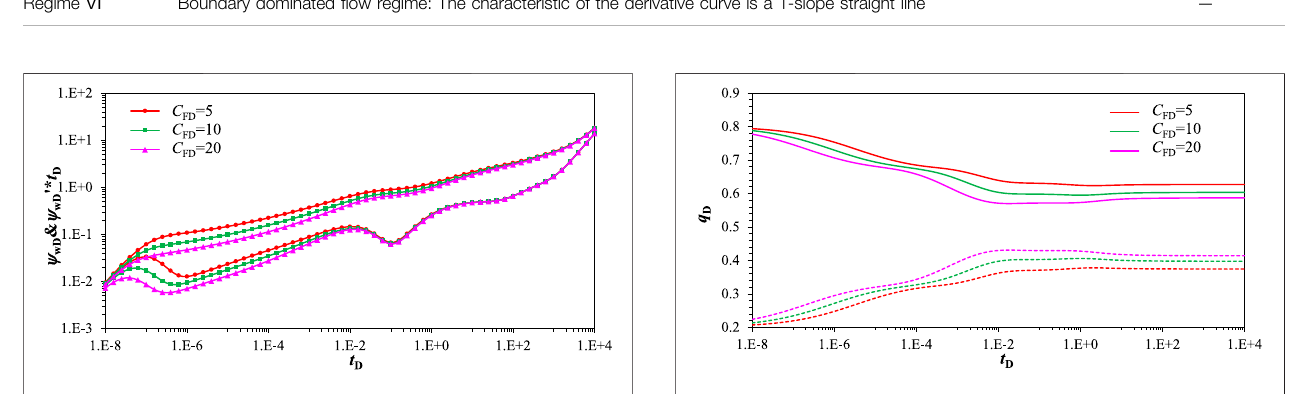
FIGURE 8 | Rate distribution curve effected by dimensionless conductivity. ( C D = 1e-5, S = 0.01, x asymD = 0.3, L F = 150 m, θ F = 90 o , R e